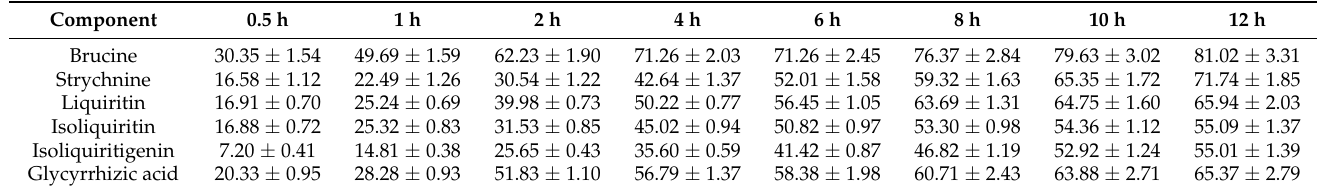
The cumulative release percentages of NG1 in distilled water, artificial gastric fluid and artificial intestinal fluid as the release media are shown in Tables 4–6. The release curves are plotted in Figure 4. The release of brucine and strychnine in artificial gastric fluid and artificial intestinal fluid was higher than in distilled water, and the highest re- lease occurred in artificial intestinal fluid, with the release rates reaching 81.02% and 71.74% after 12 h of release, respectively. The release of liquiritin in distilled water was Table 6. Percentage of cumulative release in artificial intestinal juice (mean ± SD, %). similar in artificial gastric fluid, and was about 70% after 12 h of release, but greater than that of artificial intestinal fluid. The release of isoliquiritin was lower in artificial intesti- nal fluid, reaching 55.09% after 12 h release. The release of isoliquiritigenin was the high- est in artificial gastric fluid, reaching 60.51% after 12 h, compared with 46.01% and